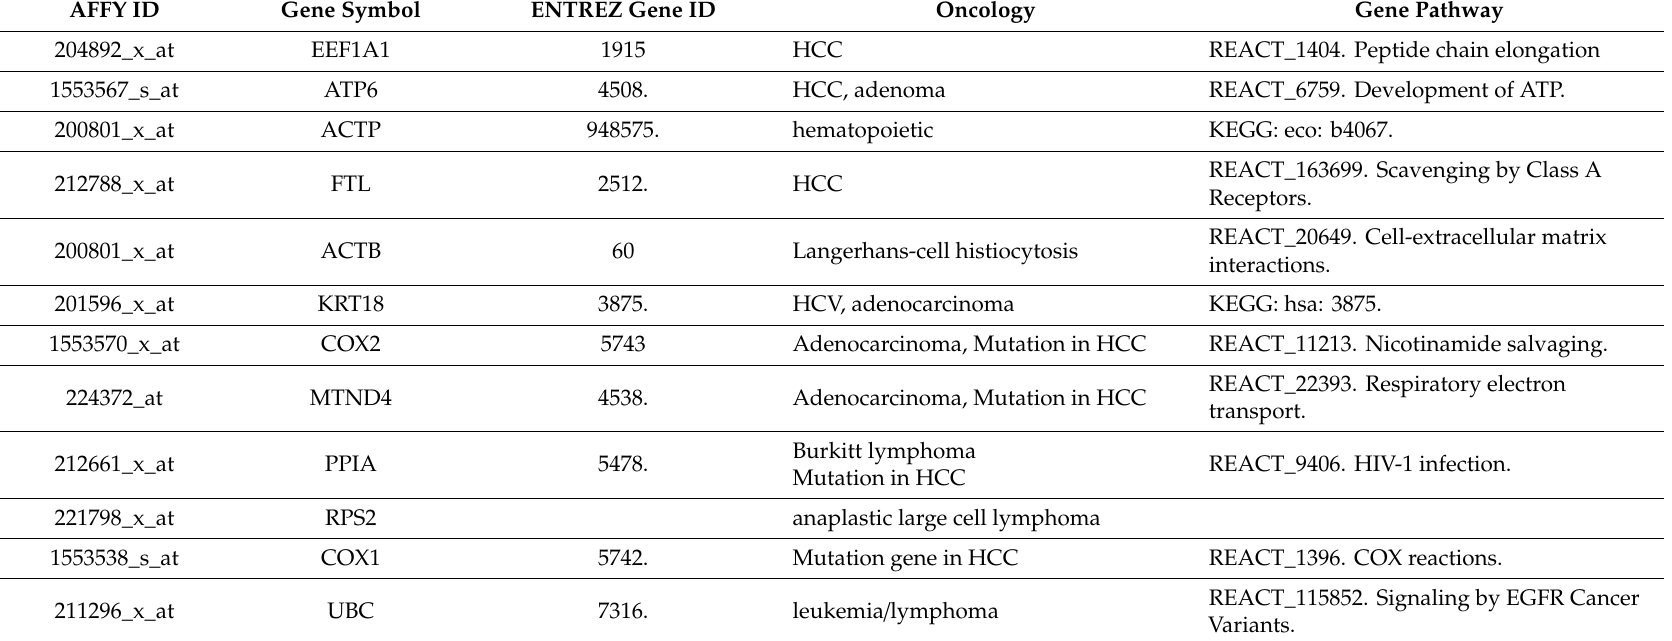
Table 4. Functional annotation of detected key genes using PCA after di ff erent periods of post-infection with C